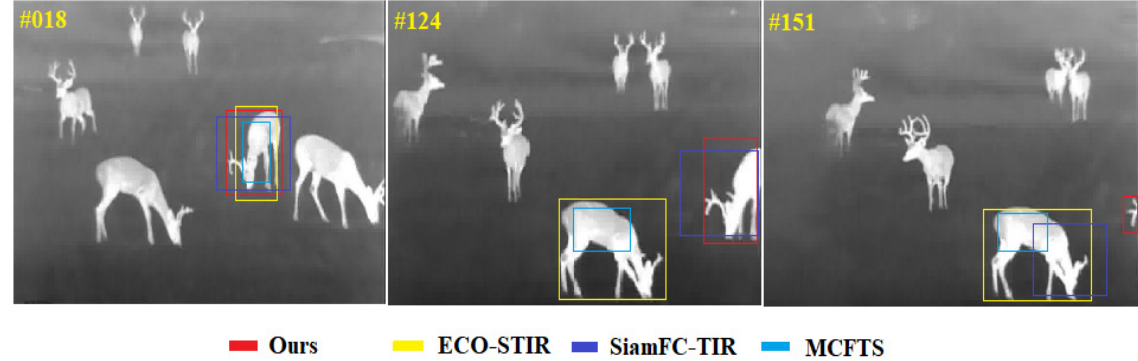
Figure 15. The visualization of tracking results in the sequence person_S_014.